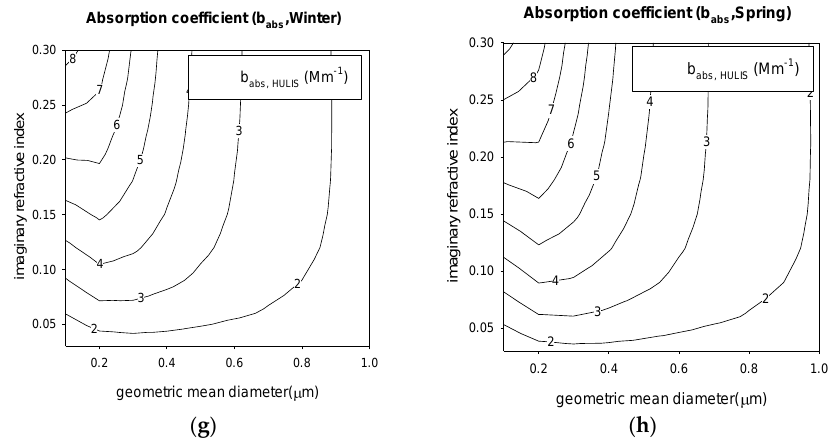
Figure 7. Contour plot of HULIS aerosol extinction coefficient in ( a ) summer; ( b ) fall; ( c ) winter; and ( d ) spring, and the absorption coefficient in ( e ) summer; ( f ) fall; ( g ) winter; and ( h ) spring with the range of various geometric mean diameters and the IRI of HULIS aerosols (0.1 µm < d g < 1.0 µm, σ g = 1.5, 0.006 < HULIS IRI < 0.3).